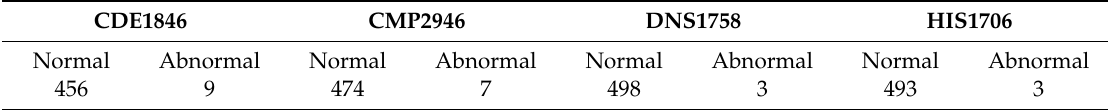
Table 9. Normal (0) and abnormal (1) e-mails for each user.